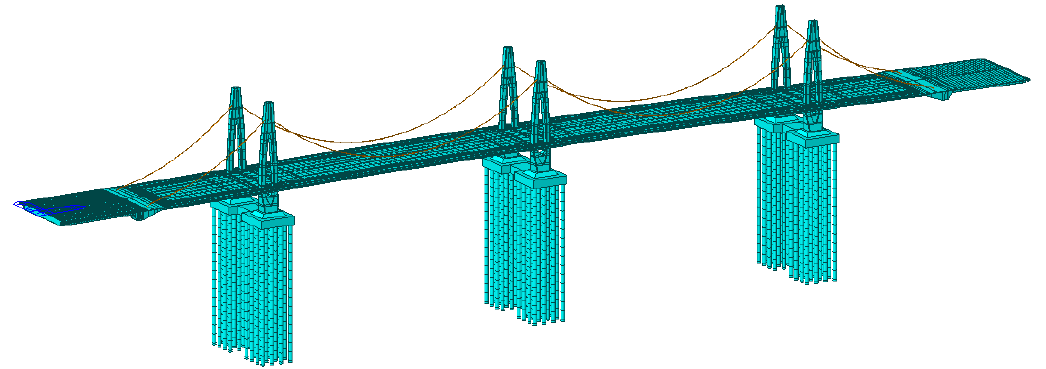
Table 1. Comparison of Calculation Results of Free Cable Shape (Unit: m).